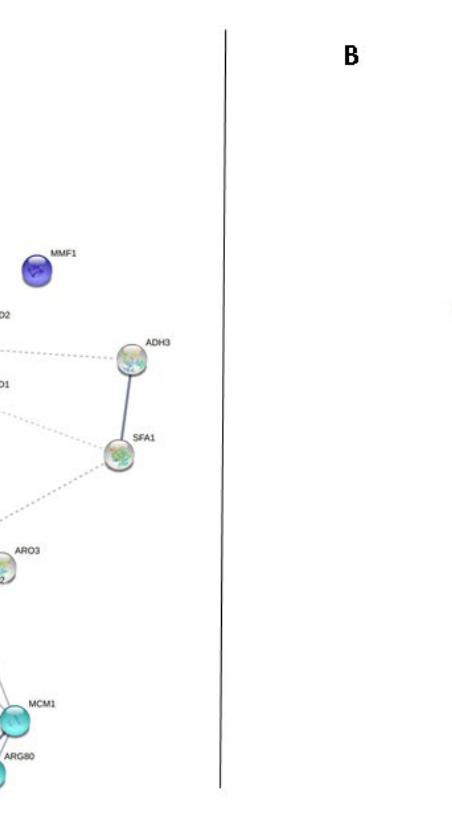
Figure 3. High confidence protein–protein interaction network map built using STRING v11 and based on the proteins of cellular amino acid metabolic process detected in S. cerevisiae P29 ( A ) and G1 ( B ) at the end of the second fermentation. Proteins are shown as nodes, and the existence of interactions between them are represented by lines (the connection between nodes). Line thickness indicates the strength of the different interactions. Nodes with the same color represent specific clusters: sulfur amino acid metabolic process (red nodes), branched-chain amino acid metabolic process (light blue nodes), glutamine metabolic process (light green nodes), glycine metabolic process (yellow nodes), glutamate metabolic process (light purple nodes), serine metabolic process (dark green nodes), arginine metabolic process (light blue nodes), and asparagine metabolic process (orange nodes).